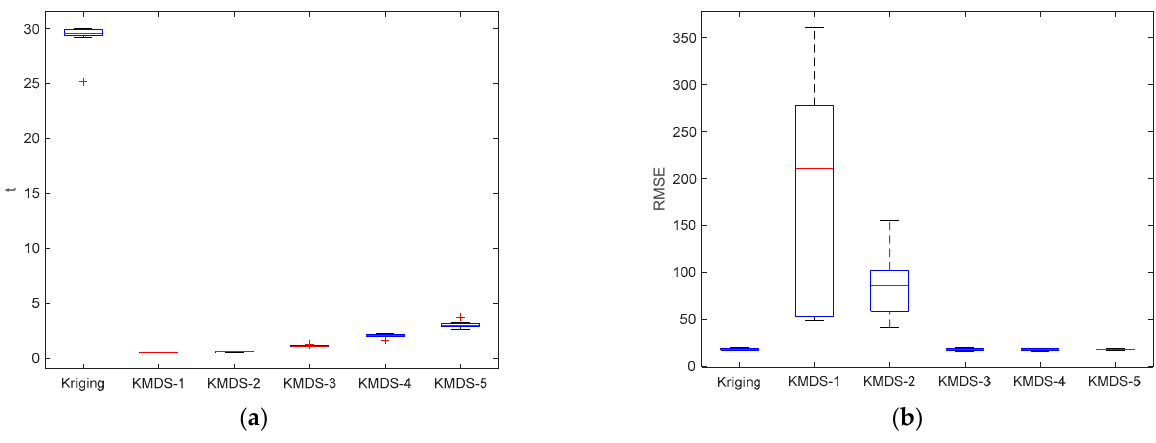
Figure 1. ( a ) Modeling time for 110 points. ( b ) Modeling error (RMSE) for 110 points.